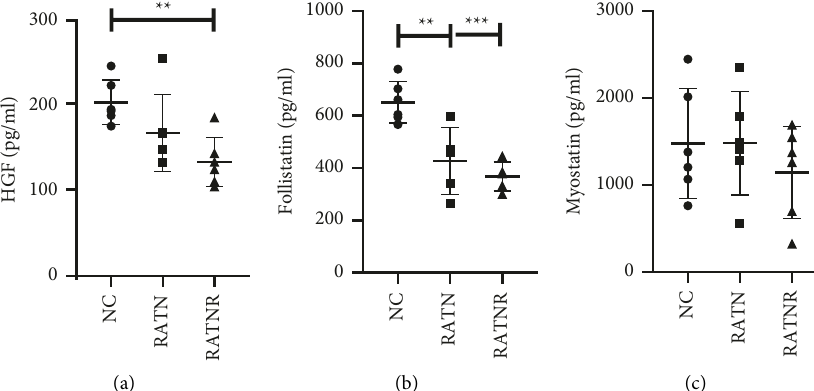
Figure 7: Triple culture supernatant muscle growth factor concentration comparing healthy (NC), RA treatment na¨ıve (RATN), and RA treatment-nonresponding (RATNR) patients. (a) HGF; (b) follistatin; (c) myostatin. Statistical analysis: one-way ANOVA (parametric: c) or Kruskal–Wallis test (nonparametric: (a b). ∗∗ � p < 0 . 01; ∗∗∗ � p < 0 . 001. n � 6 per group. Data represented as mean ± SD. HGF � hepatocyte growth